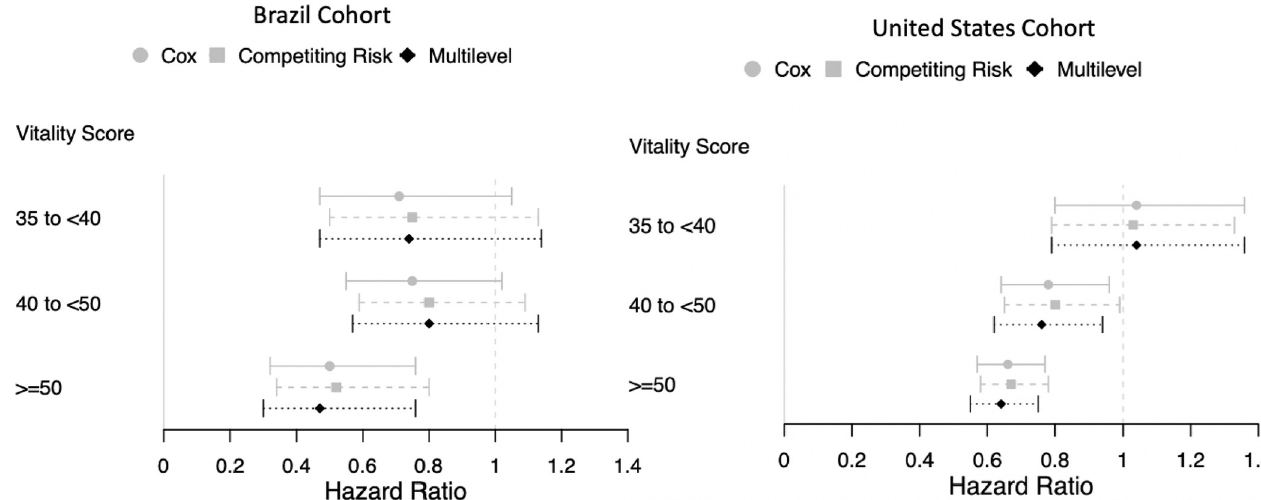
Fig 2. Forrest Plot of model estimates in the cohorts from Brazil and the United States. Models are adjusted for history of diabetes, coronary artery disease, peripheral artery disease, previous history of HD treatment, initial PD modality, hemoglobin, creatinine, and age.